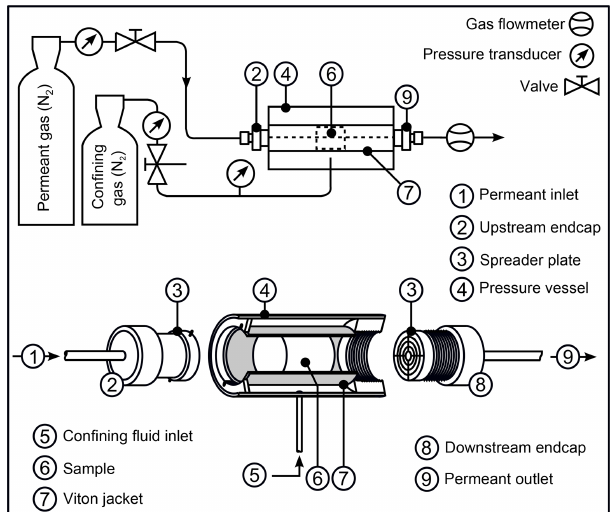
Figure 2. Schematic of the benchtop gas permeameter used for this study (modified from Farquharson et al., 2016; Heap and Kennedy, 2016).